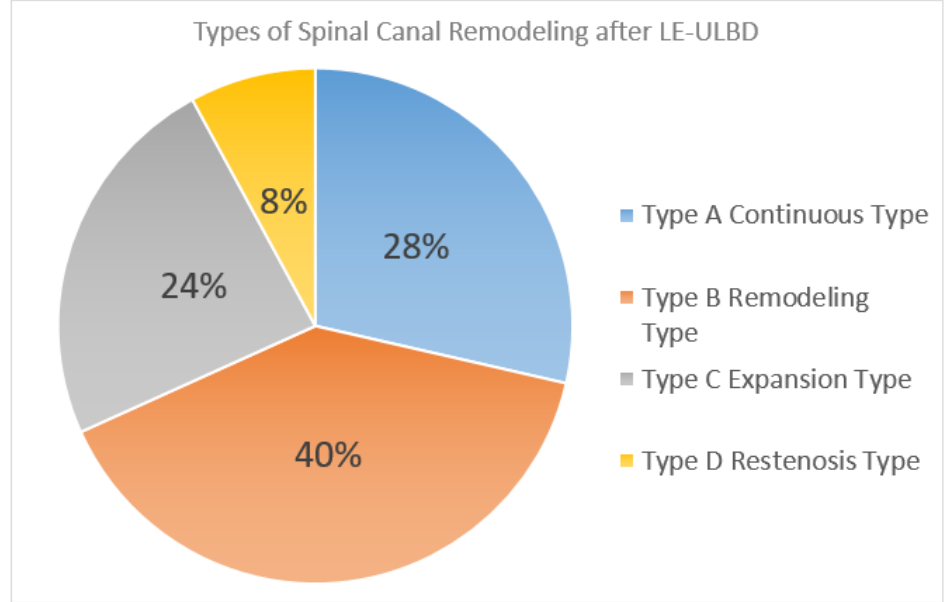
Figure 9. Distribution pie chart of the various types of spinal canal remodeling pattern after lumbar endoscopic unilateral laminotomy with bilateral decompression (LE-ULBD). Type A: continuous expanded spinal canal, type B: restenosis with delayed expansion, type C: progressive expansion and type D: restenosis.